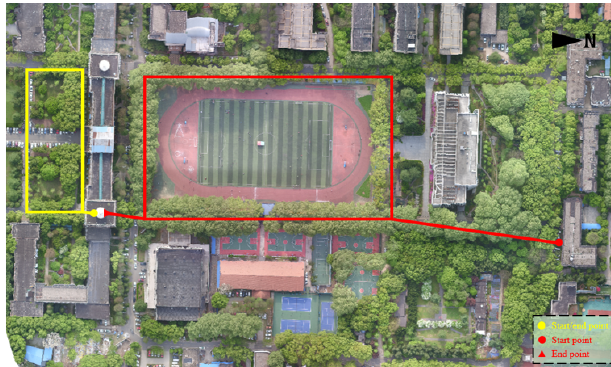
Figure 5. Experiment sites shown in corresponding UAV image.